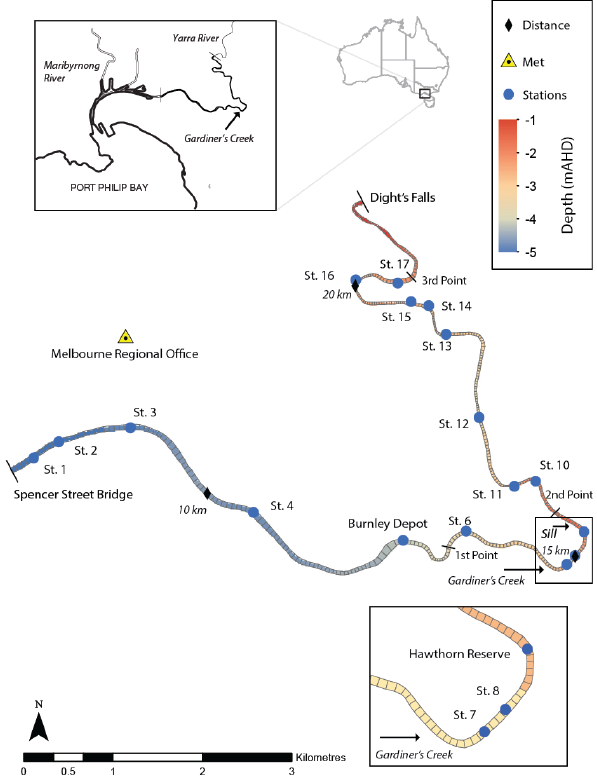
Fig. 1. Study site (see inset for location), computational mesh and bottom depth elevation relative to Australian Height Datum (m). Sampling stations described in Table A1.